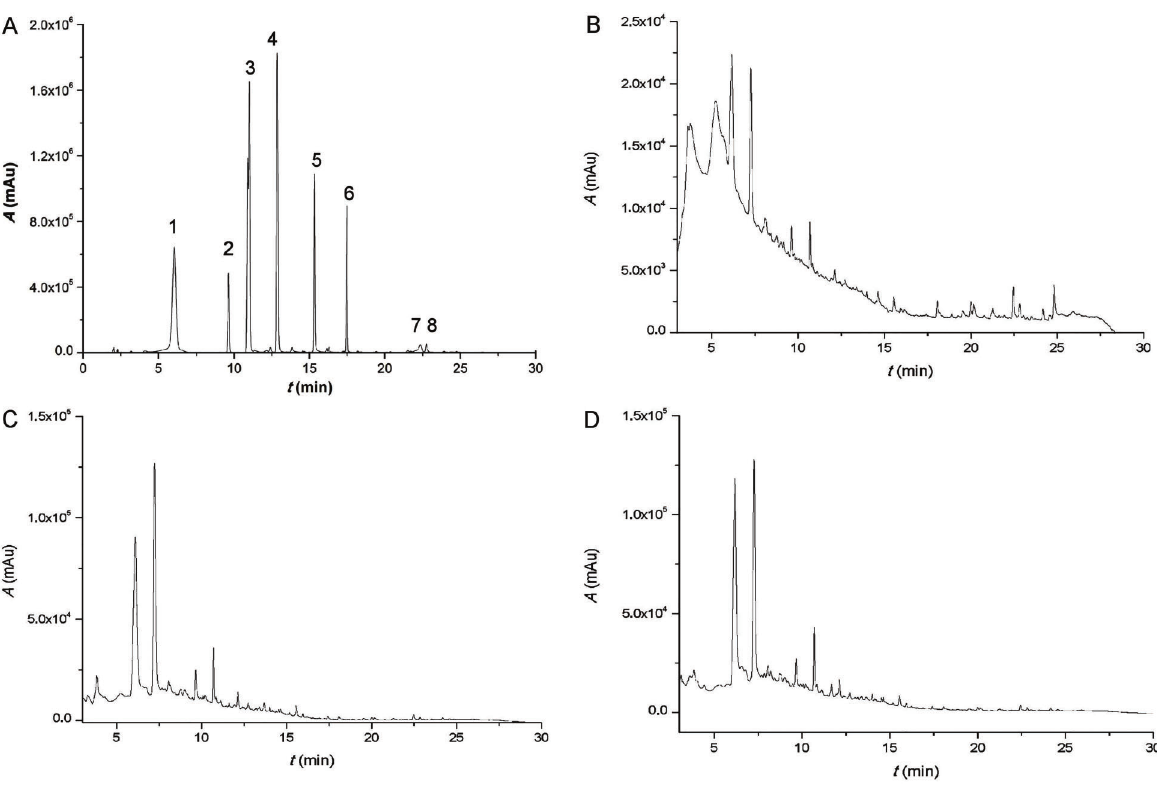
Figure 2. High performance liquid chromatography (HPLC) results of melon peel extracts. A , Standard calibration curve. B , Aqueous extract. C , Hydroethanolic extract. D , Hydromethanolic extract. Standards: 1: gallic acid; 2: salicylic acid; 3: ellagic acid; 4: catechin; 5: quercetin; 6: vanillin; 7: eugenol; 8: vanillic acid. Table 2. Quanti fi cation of total phenolic compounds, total fl avonoids and tannins and antioxidant properties (total antioxidant capacity, TAC), reducing power, DPPH radical-scavenging effect and ORAC assay of melon peel and seed extracts. Bioactive compounds and antioxidant Melon peel extracts (dry activities